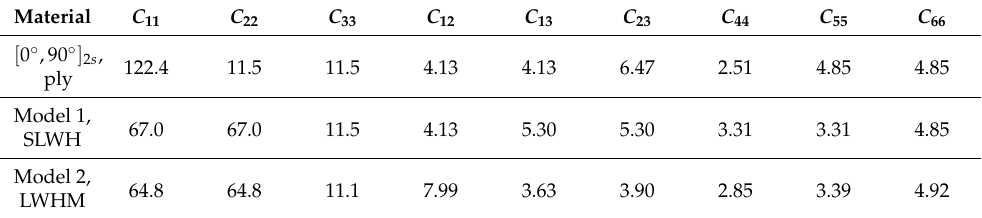
Table 1. Elastic properties of a single ply and of a homogenized waveguide